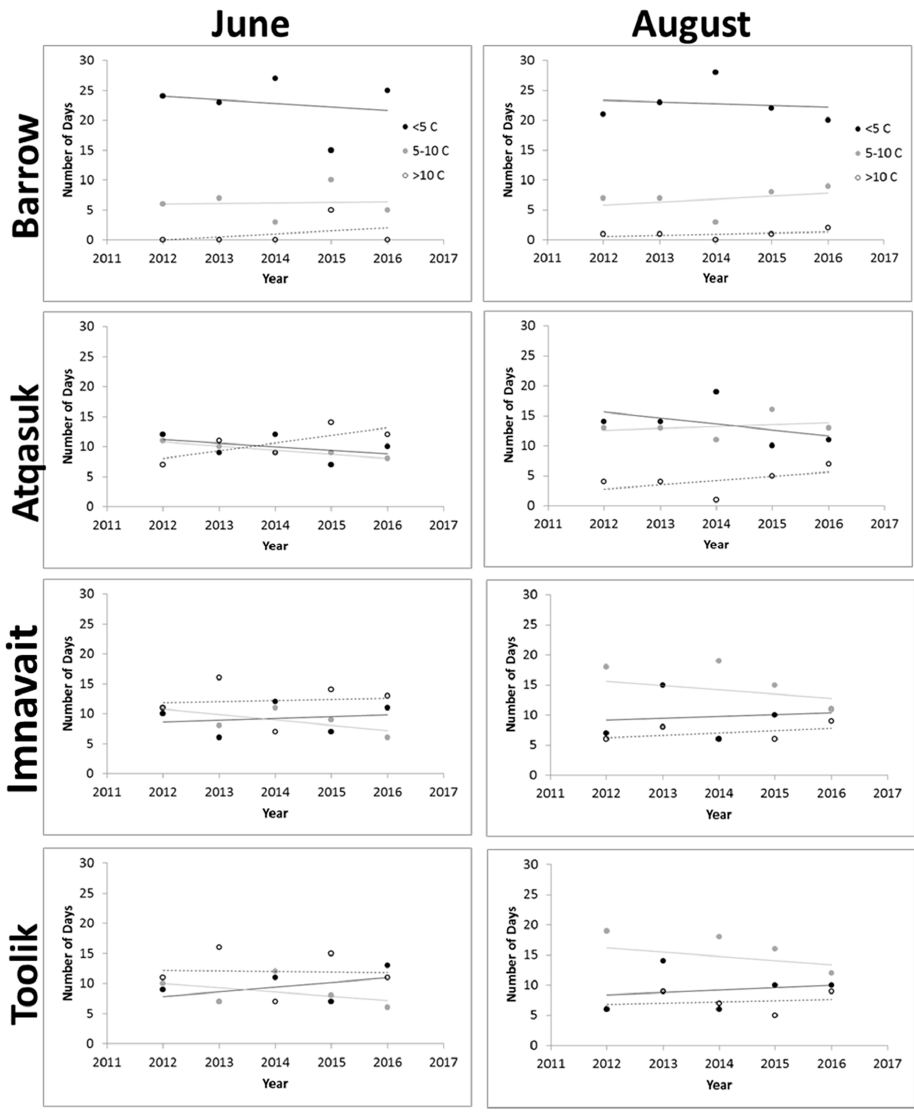
Figure 2. Number of days during June and August of 2012–2016 that were <5 °C (solid black circles, solid black linear line of best fit), 5–10 °C (solid grey circle, solid grey linear line of best fit), and >10 °C (open black circles, and dashed black linear line of best fit).